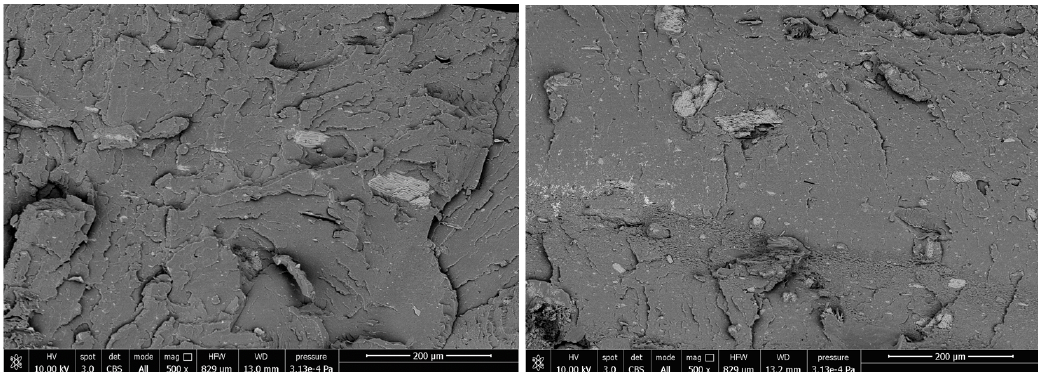
Figure 9. Back Scattering Images of base + 10 (left) and base + 20 (right) biocomposites.